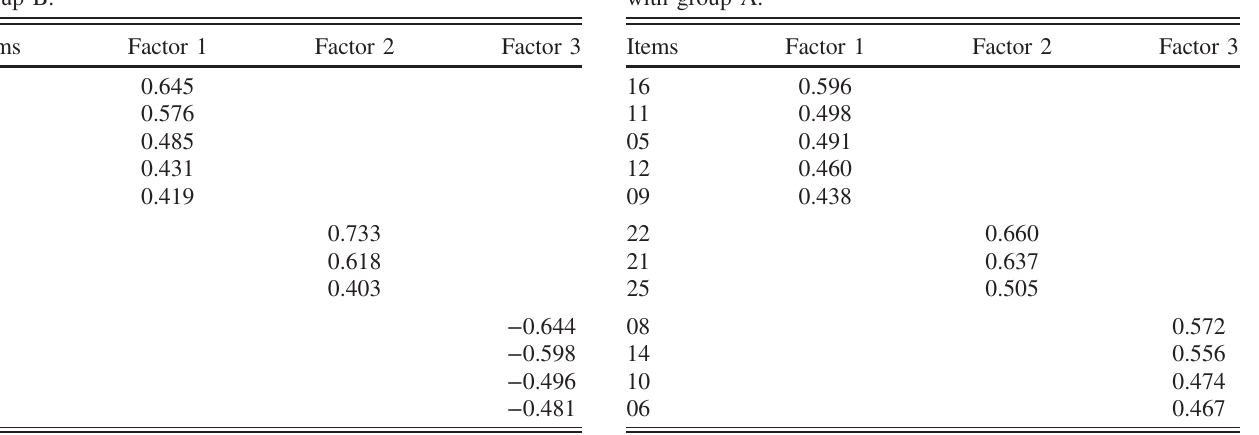
TABLE X. Finalized factor loadings for group A. Loadings less than 0.25 have been suppressed. EFA involved approximately half of the section 1 students. These loadings represent results after a filtering of the original 30 items and a comparison with group B.